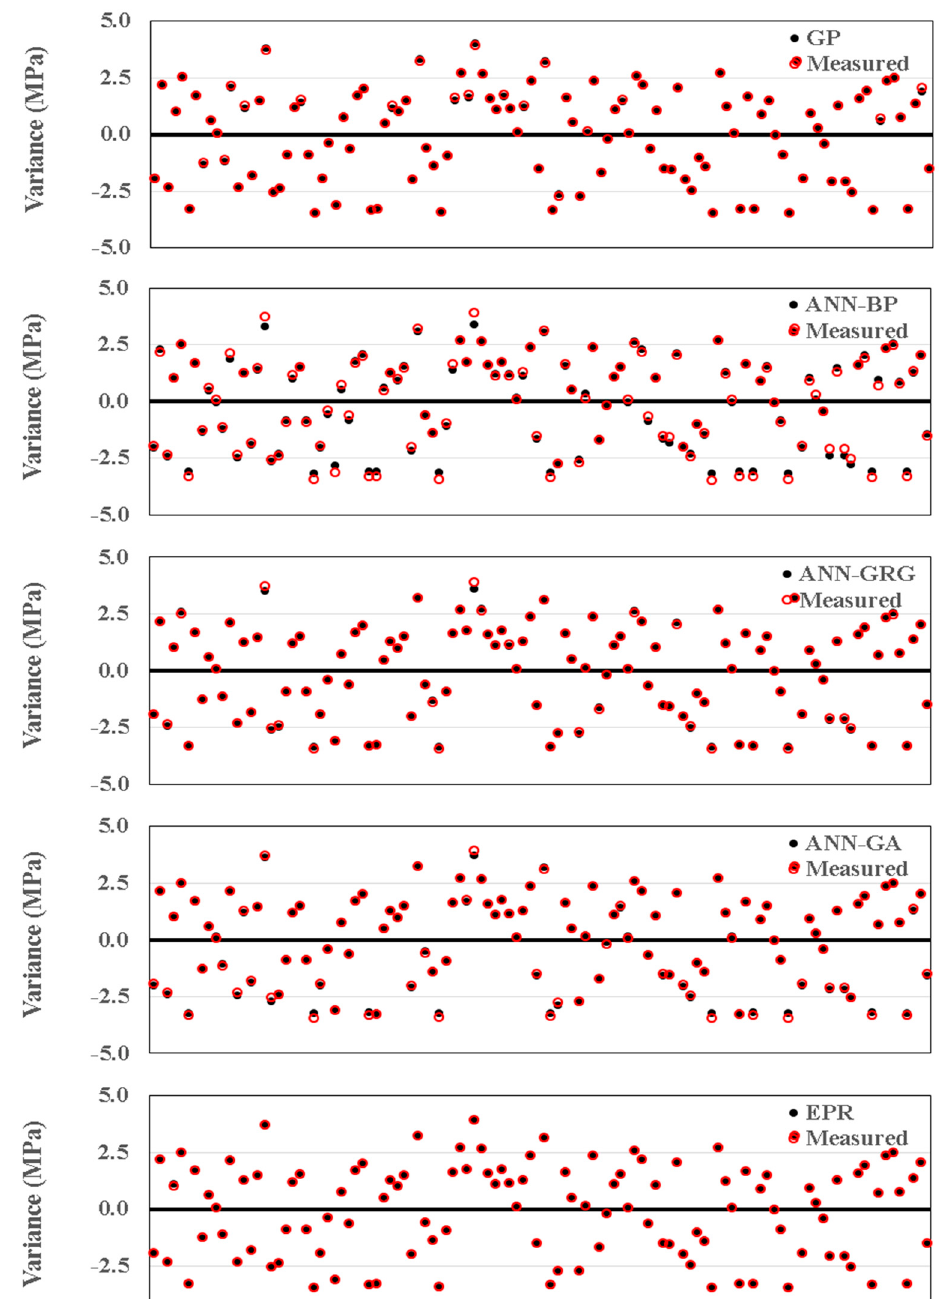
Figure 7. Comparison between developed models for P using variance diagrams.